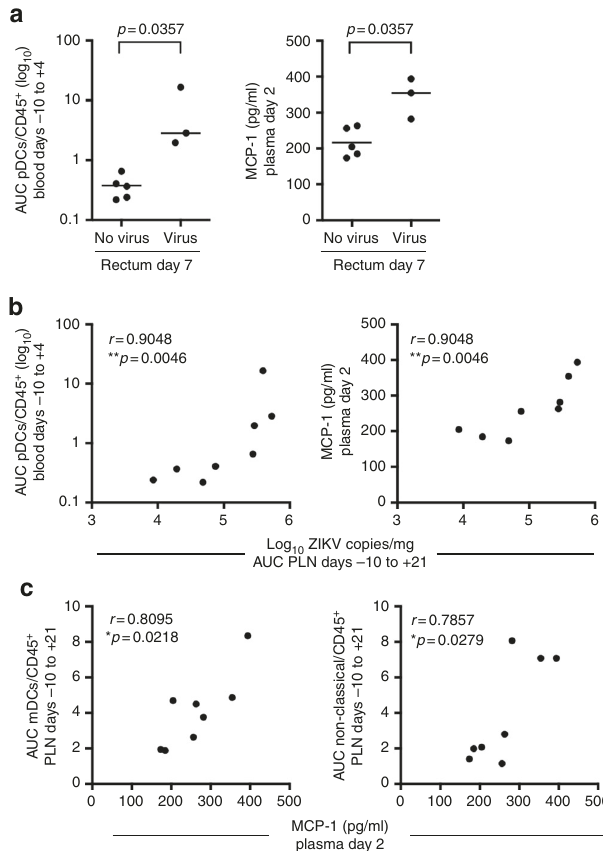
Fig. 5 Innate responses in the blood recruit viral targets to tissues and promote viral persistence. a Early cellular innate immune responses in PTM with and without detectable ZIKV RNA in the rectum at day 7. Each panel shows the AUC of pDCs measured by fl ow cytometry in the blood between days − 10 to + 4 or the concentration of plasma MCP-1 measured at 2 dpi in animals with or without detectable ZIKV in the rectum at 7 dpi. Lines indicate the median. Differences between animals with no virus or virus in the rectum were evaluated using Wilcoxon tests. Unadjusted p -values are shown. b Correlations between viral burden in the PLN (AUC, days − 10 to + 21) and either pDC frequency (AUC, days − 10 to + 4) in the blood (left panel) or the concentration of plasma MCP-1 measured at 2 dpi (right panel). c Scatter plot and Spearman's correlation analysis of the relationship between the concentrations of plasma MCP-1 measured at 2 dpi and mDCs (AUC, days − 10 to + 21) and non-classical monocytes (AUC, days − 10 to + 21) in the PLN. Signi fi cance of the unadjusted Spearman's correlation test p -values are indicated as follows: * p ≤ 0.05, ** p ≤